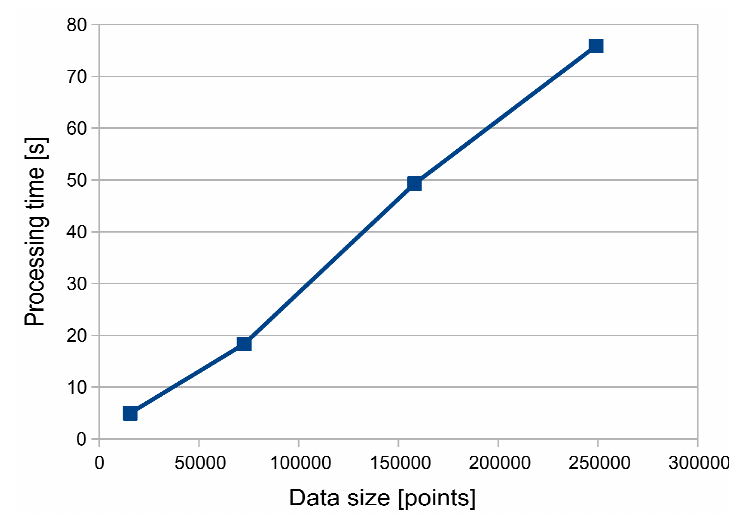
Figure 7. Scaling of processing time in relation to size of input data.